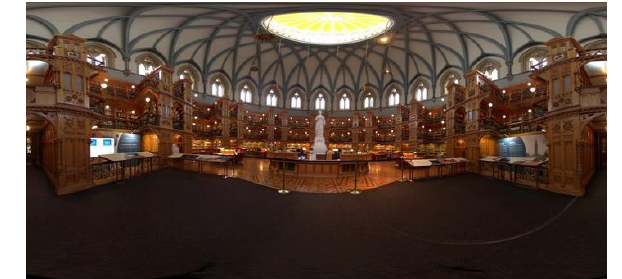
Figure 4. Panoramic image.